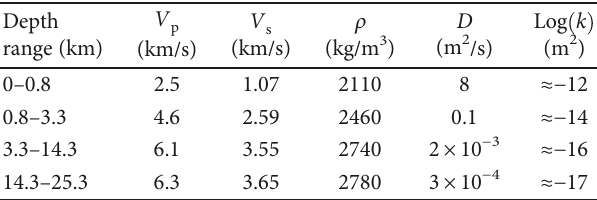
Table 1: Elastic and hydraulic parameters used in the two tested scenarios S1 and